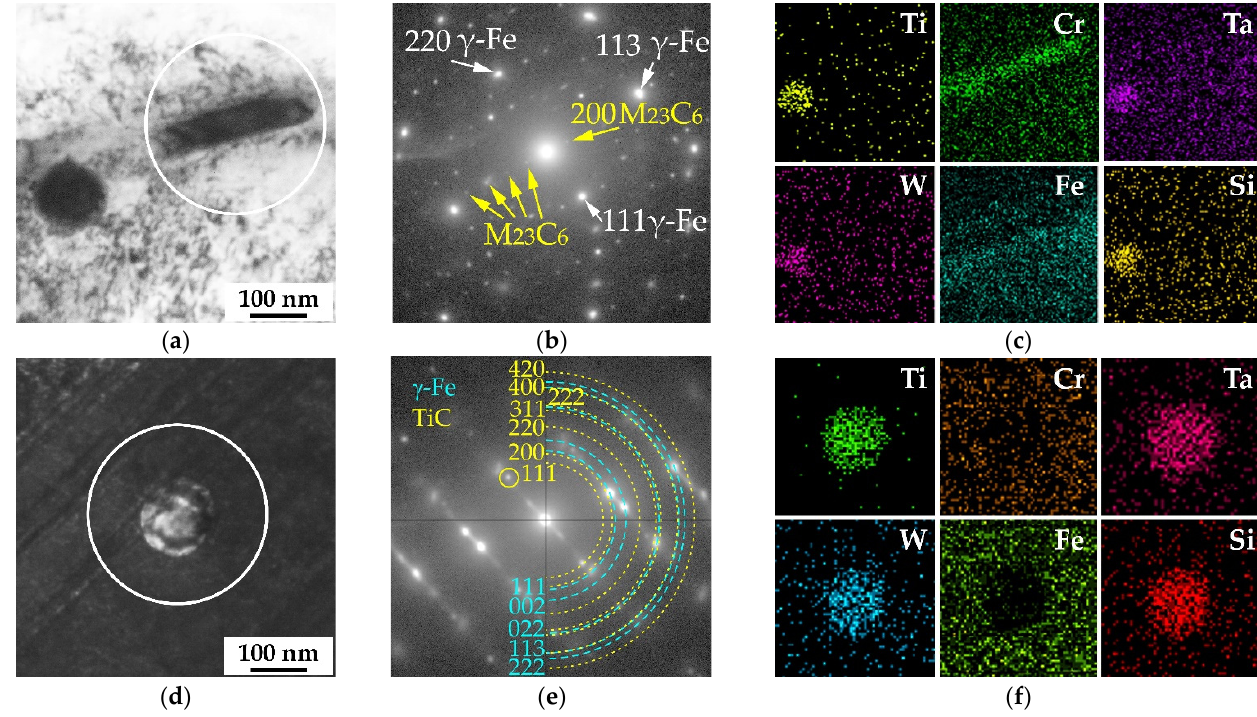
Figure 7. TEM BF and DF images of dispersed particles ( a , d ), corresponding SAED patterns from area marked by white circles ( b , e ), reflections of matrix and particles are denoted by white and yellow arrows, respectively, EDX elemental maps from particles ( c , f ): ( a – c )—ST, ( d – f )—CR.